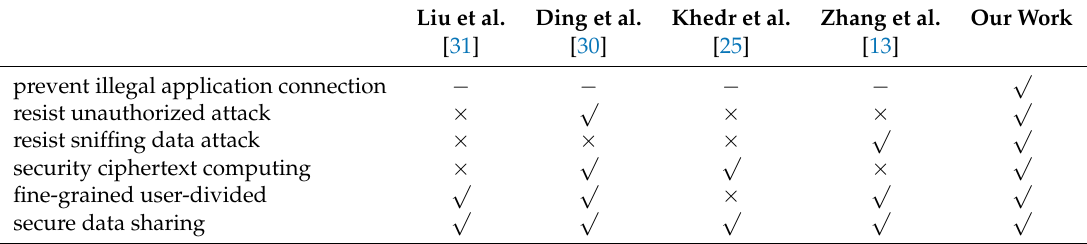
Table 3. Comparison with different